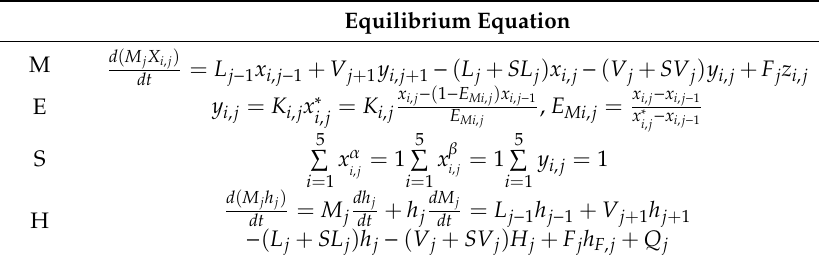
Table 2. Dynamic mathematical model of the distillation column.